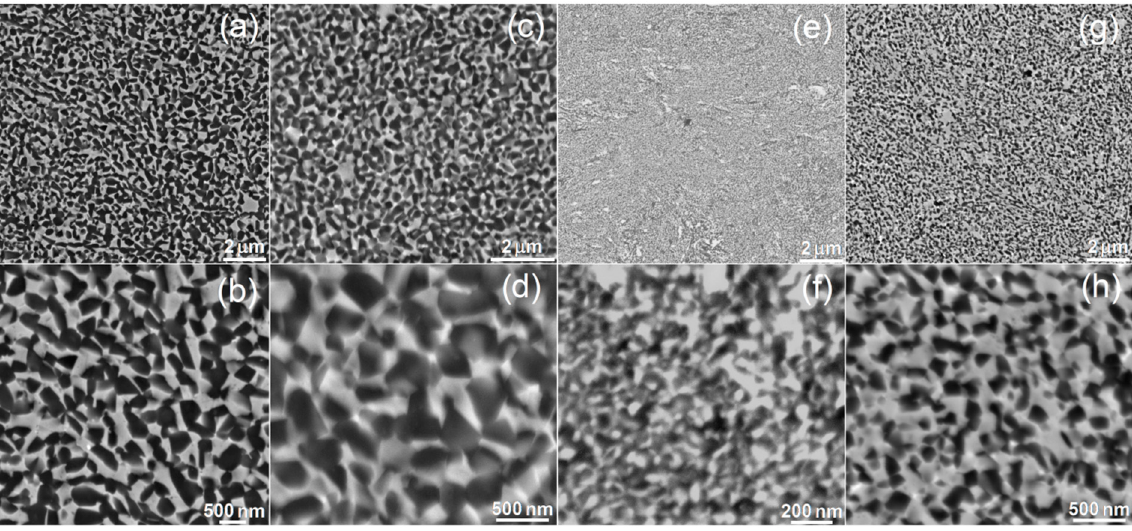
Figure 2. SEM micrographs of the ( a , b ) Ti30Ta3Ag, ( c , d ) Ti30Ta5Ag, ( e , f ) Ti40Ta3Ag, and ( g , h ) Ti40Ta5Ag microstructure—various magnifications.